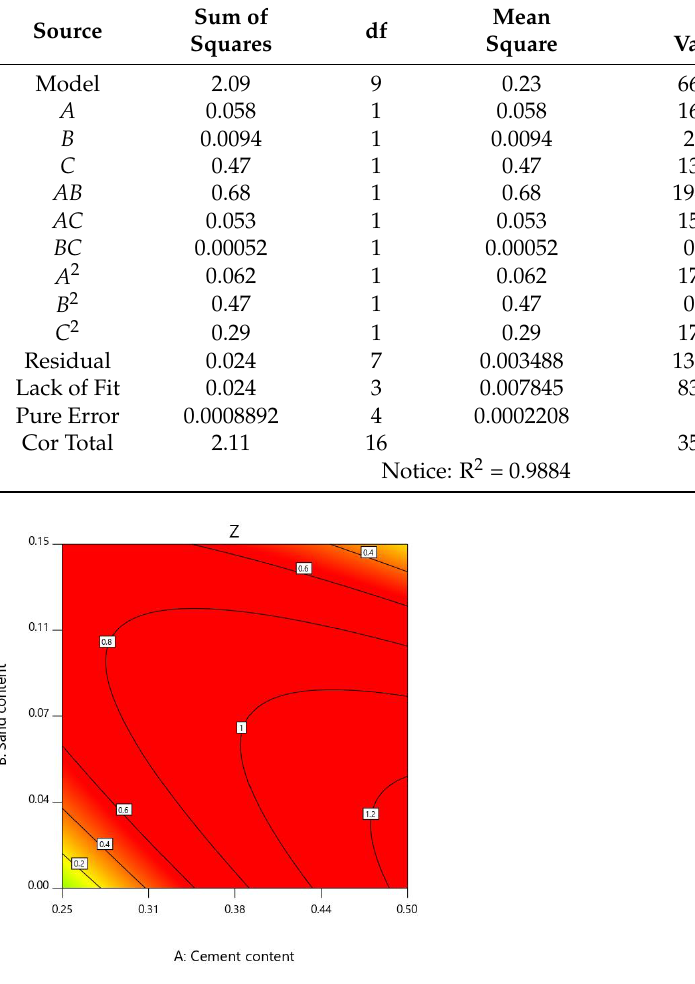
Figure 8. Contour Figure 8. Contour map.